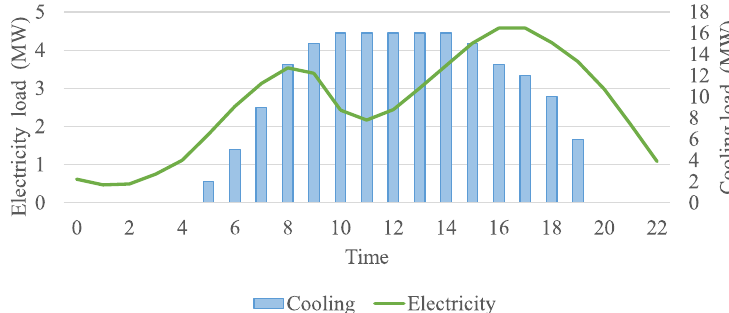
Figure 6. Load demand profiles of the example.